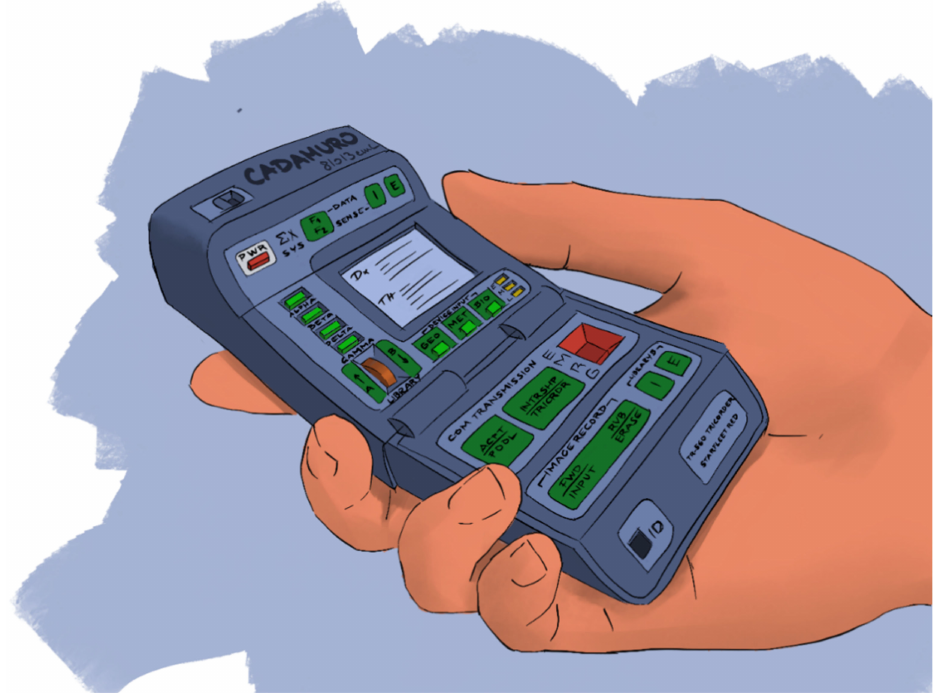
Figure 5. The medical tricorder from Star Trek —The future of medical